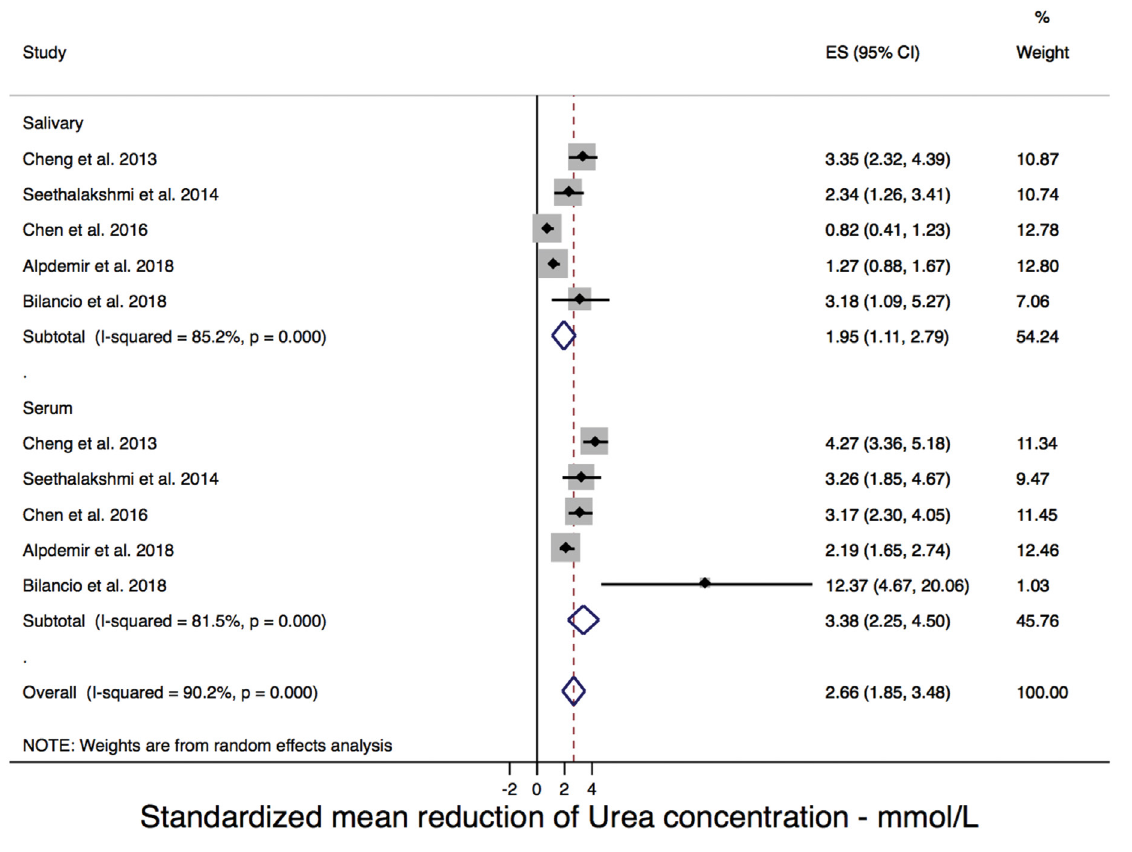
Figure 3A. Forest plot of the difference in urea concentrations from pre- to posthemodialysis meta-analysis of Hedges standard mean difference (g) of urea concentration. Weights are from random effects